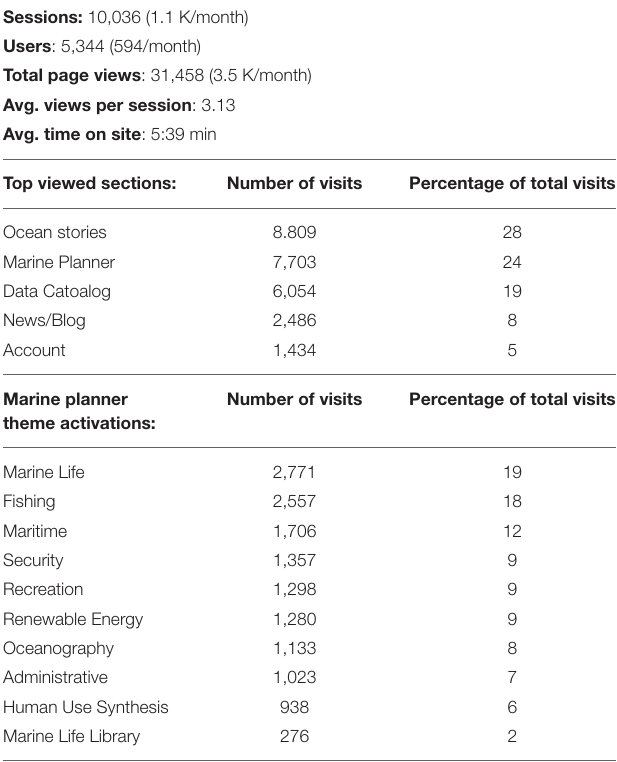
TABLE 1 | Portal Analytics March 8-December 8,